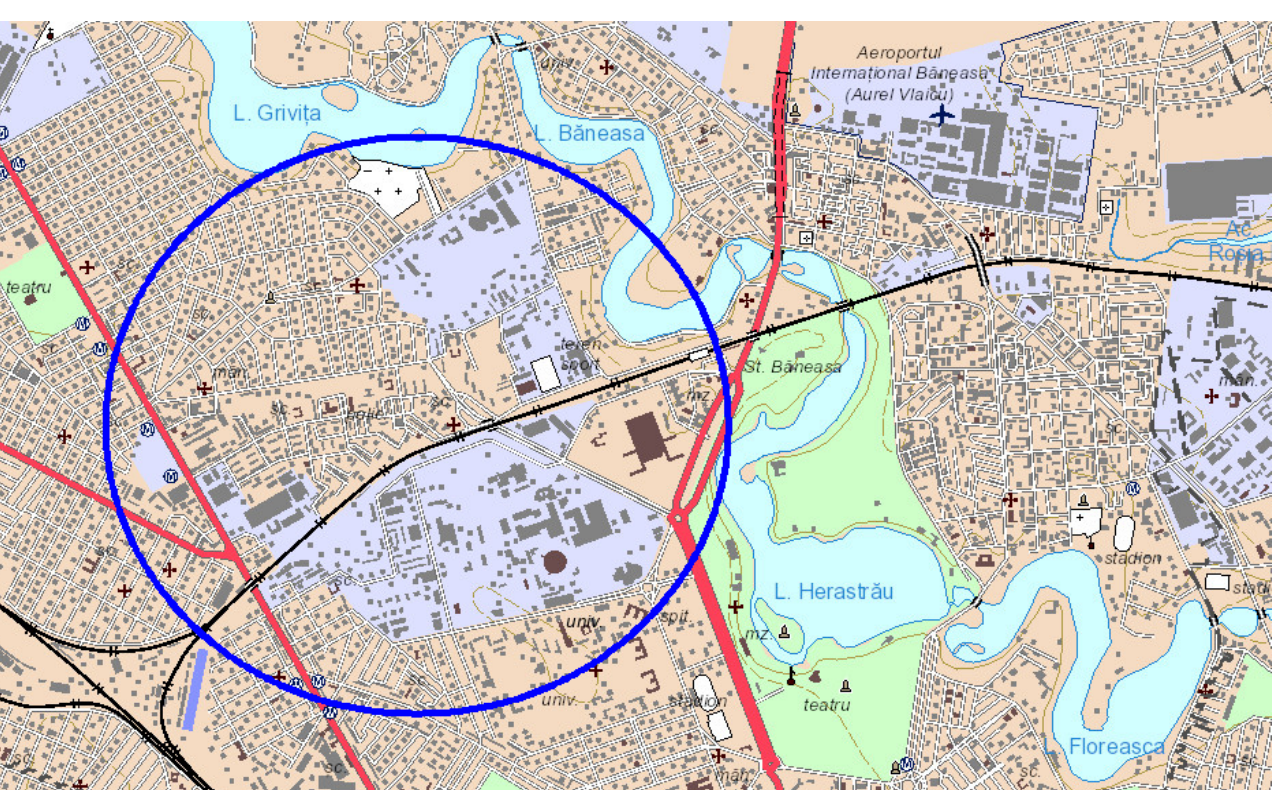
Figure 9. Property in B ă neasa Forest (purple area within the blue circle) based on data from the Office of Cadastre and Real Estate. The map displays property limits, based on different ownerships, showing that the forest can be divided into smaller parcels and owners can change the land use if protection ceases.